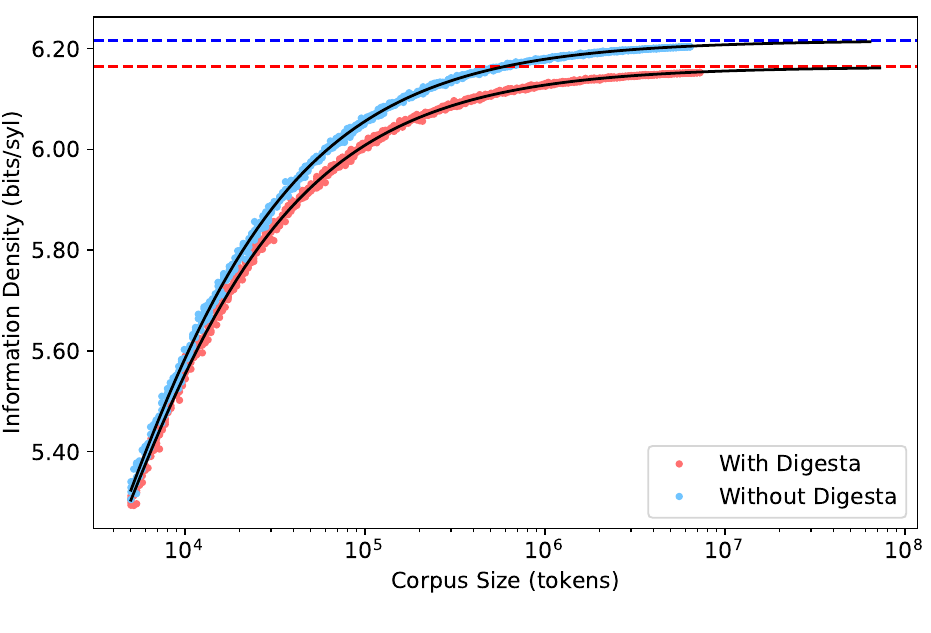
Figure 3. Estimated information density with and without the